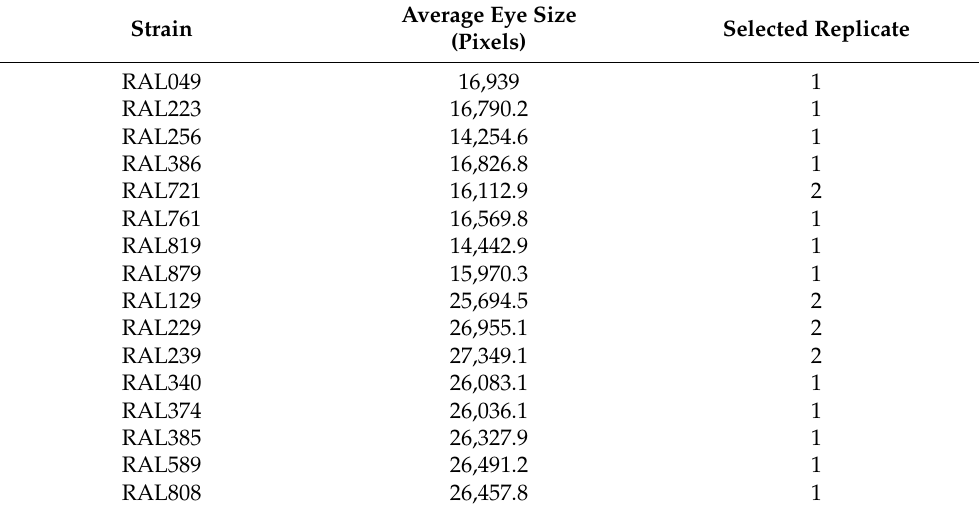
Table 3. Replicates selected for each strain in the best replicate combination. Strain